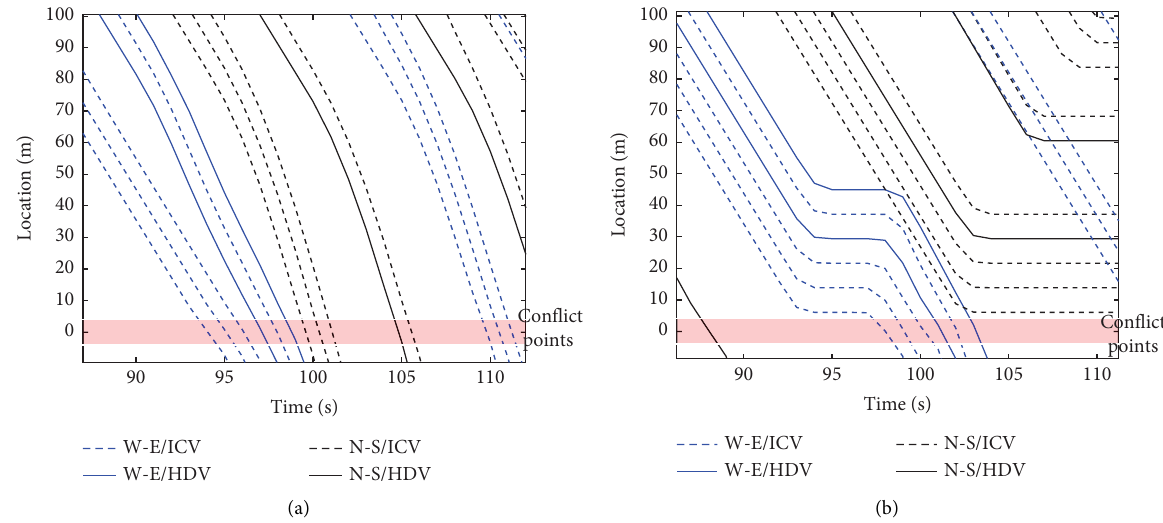
Figure 7: Position-time curve of mixed vehicle cooperative driving. (a) Trajectories of the proposed method. (b) Trajectories of the benchmark method.